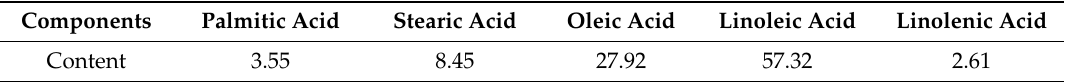
Table 4. The main components of cottonseed oil (wt